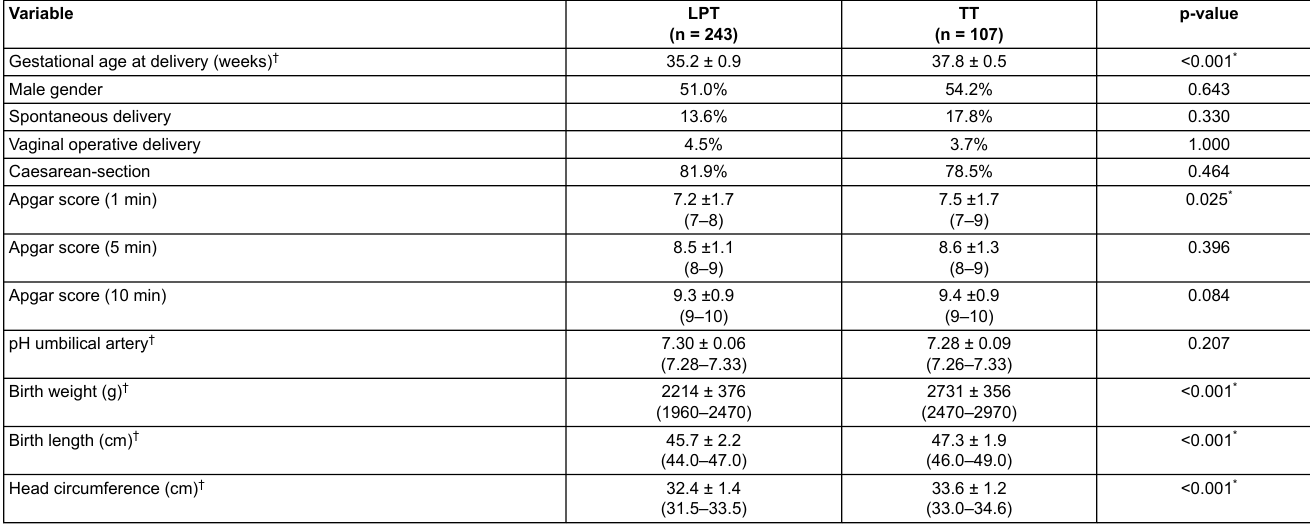
Table 2: Characteristics at birth of late preterm twins compared with term twins. Variable